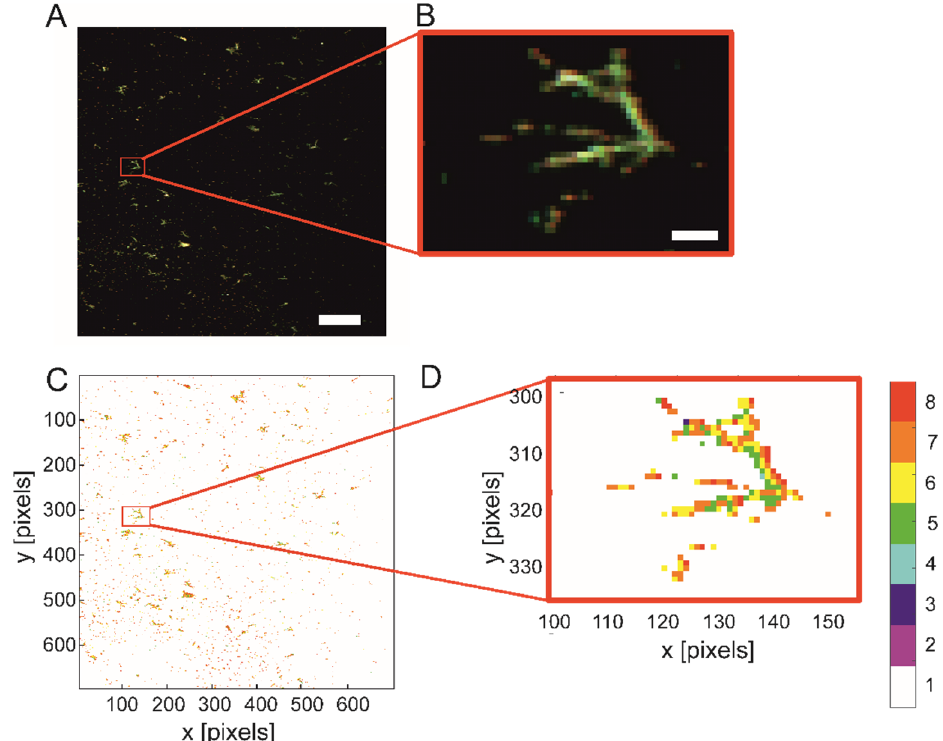
Figure 2. Dark field scattering data set of silver nanoparticles. ( A ) RGB image based on scattering intensity at 660 nm, 540 nm, and 470 nm. Scale bar: 20 µm. ( B ) Magnification of a region of interest. Scale bar: 2 µm. ( C , D ) Visualization of the result of a classification analysis generating eight clusters that represent scattering signals at different spectral regions: Cluster 1, white, no signal, Cluster 2, magenta, 400–450 nm, Cluster 3, blue, 450–490 nm, Cluster 4, cyan, 490–520 nm, Cluster 5, green, 520–560 nm, Cluster 6, yellow, 560–590 nm, Cluster 7, orange, 590–635 nm, Cluster 8, red, >635 nm.